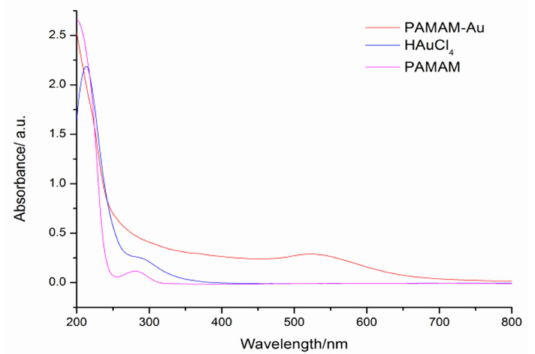
Figure 1. UV–VIS adsorption spectra of HAuCl 4 , PAMAM, and PAMAM-Au nanocomposites in their aqueous solution (1 mM HAuCl 4 , 0.07 mM PAMAM, and the 10-fold diluted as-synthesized